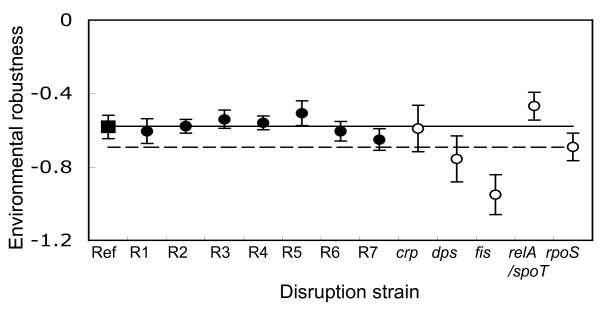
Robustness of random and hub deletion mutants to environmental stress. Average of median values measured in each environment is plotted for each strain. Error bars indicate standard errors. Reference strain (ref), solid square, random disruption strains, solid circles; targeted hub disruption strains, hollow circles. Solid line indicates mean of random disruption strains; dotted line indicates mean of targeted hub disruption strains.